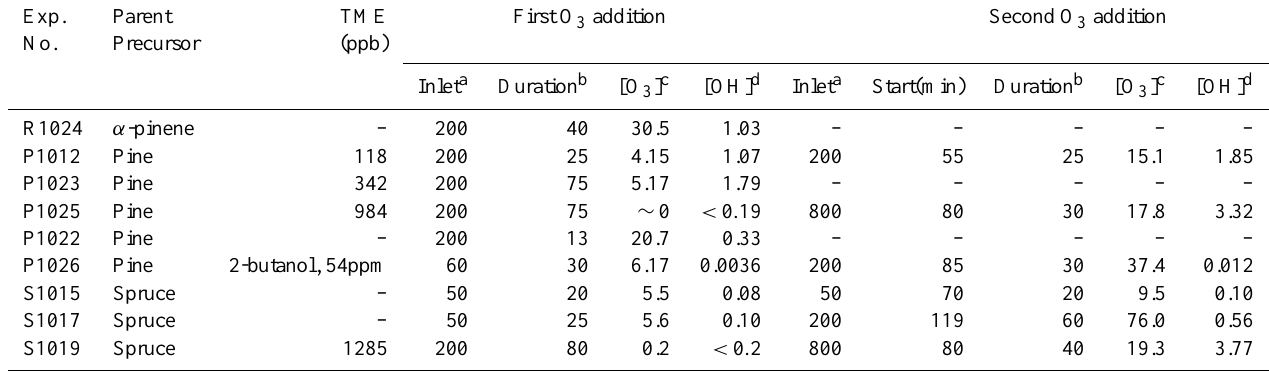
Table 1. Initial conditions of chamber operation ( P , S and R codes are for Scots pine, Norway spruce and α -pinene, respectively).